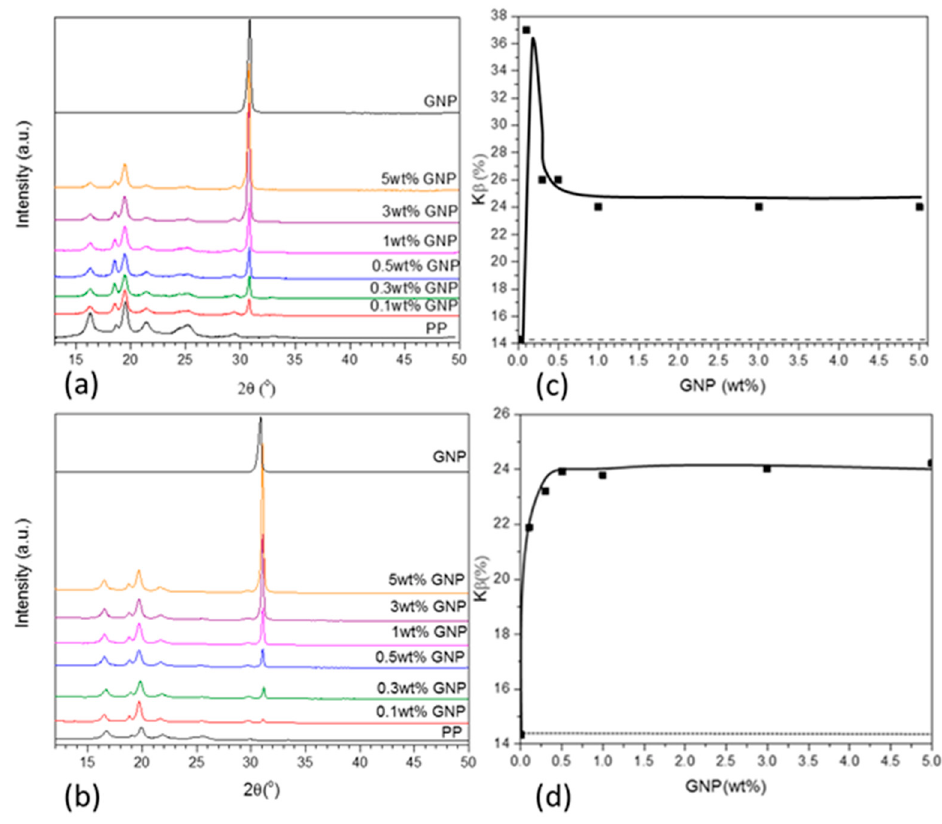
Figure 3. XRD patterns of PP, GNPs, and their composites at different GNP loadings prepared with ( a ) a laboratory scale extruder and ( b ) a 16-mm extruder, and the fraction of β -polymorph formed ( K β ) as a function of GNP loading for composites prepared by ( c ) a laboratory scale extruder and ( d ) a 16-mm extruder.